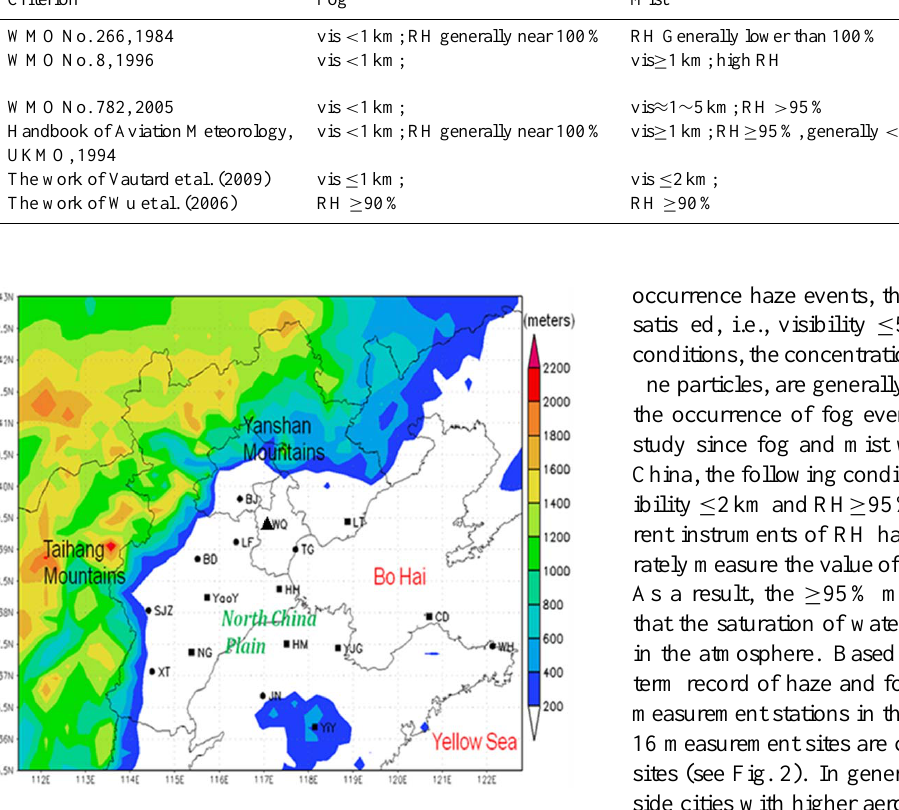
Table 1. The criterions of fog, mist and haze by visibility and RH Criterion